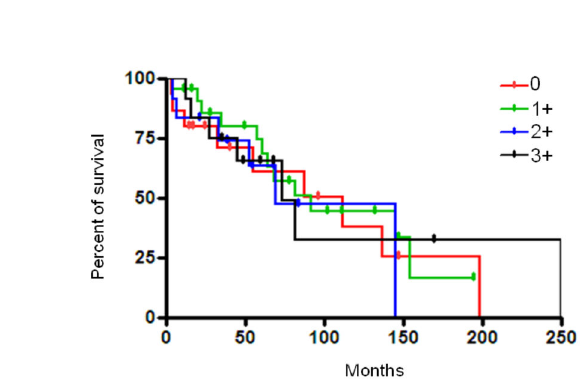
Figure 2. Analyses of association between expression of brachyury and survival for